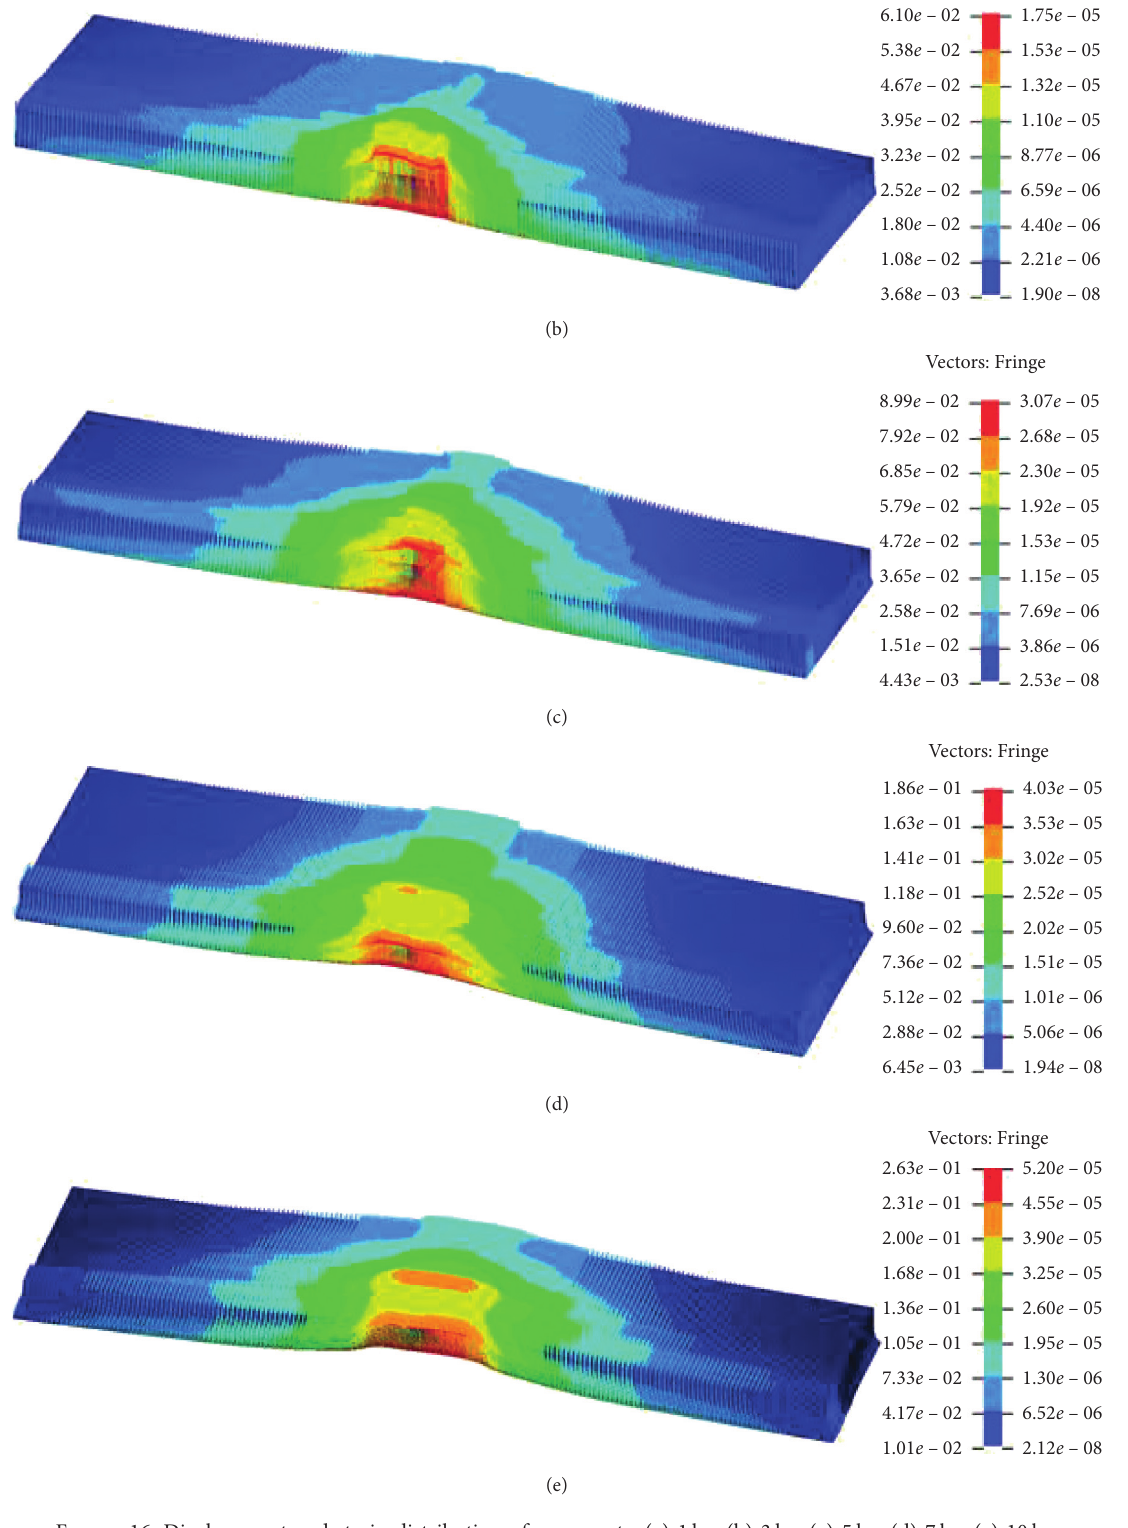
Figure 16: Displacement and strain distribution of pavements. (a) 1kg. (b) 3kg. (c) 5kg. (d) 7kg. (e)